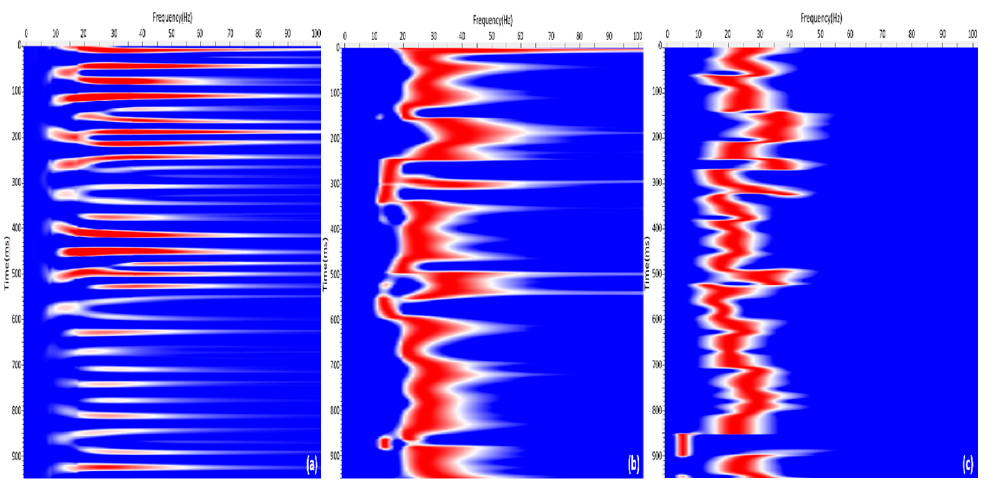
Figure 3. The comparison of time-frequency spectra of a synthetic seismic trace. From left to right, the